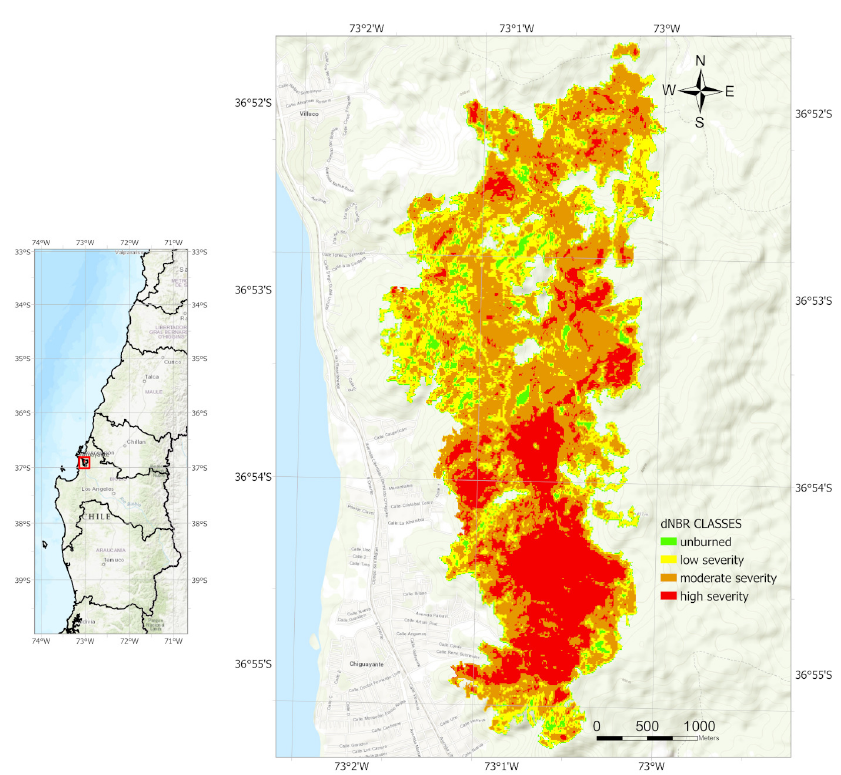
Figure 1. Right: ’MIRADOR STA JUSTINA’ fire location (red frame) in relation with Central Chile. Left: Example of fire severity map as measured with dNBR for the ’MIRADOR STA JUSTINA’ fire, which affected more than 5 ha. during 2019. The map shows the area unburned and the areas affected with low, moderate, and high